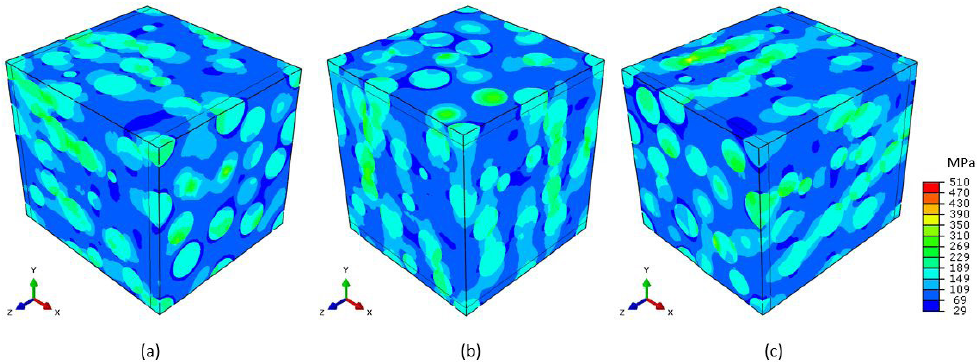
Figure 12. Principal stress fields on RVE under different tension loading states in the deformed configuration.